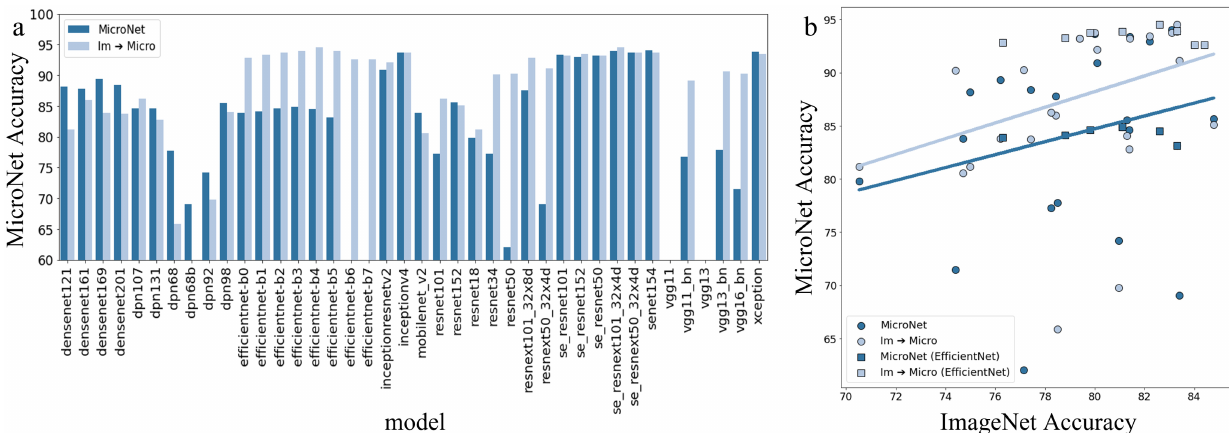
Fig. 2 Accuracy of classi fi cation models. a The prediction accuracy of classi fi cation models on the MicroNet validation set. The models indicated with dark blue were randomly initialized and trained from scratch while the “ Im → Micro ” models shown in light blue were pre- trained on ImageNet and then fi netuned on the MicroNet data. b Comparison of each architecture ’ s reported accuracy when trained to classify ImageNet data versus each architecture ’ s the classi fi cation accuracy when trained to classify MicroNet data in this study. Ef fi cientNet models are indicated with square markers and all others with circular markers. dark contrast images. The performance of the best models pre- Table 1. Number of images in the train, validation, and test splits of trained on MicroNet and ImageNet for each of the Super-1 to each experimental Super-3 datasets are displayed above the segmentation accuracy masks in Fig. 3. When training on Super-1 with ten training images (Fig. 3b, fi rst row), both the ImageNet and MicroNet models performed well and accurately segmented the secondary and tertiary precipitates. On Super-2 with only four training images (Fig. 3b, second row), the MicroNet model had only a slight reduction in accuracy (96.4% IoU to 94.2% IoU) while the ImageNet model had a large reduction in accuracy from 96.5% to 88.7%. With four training images the ImageNet model failed to identify many of the tertiary precipitates in the dark contrast images as indicated by the yellow triangles. The ImageNet model also over-segmented and combined some of the secondary